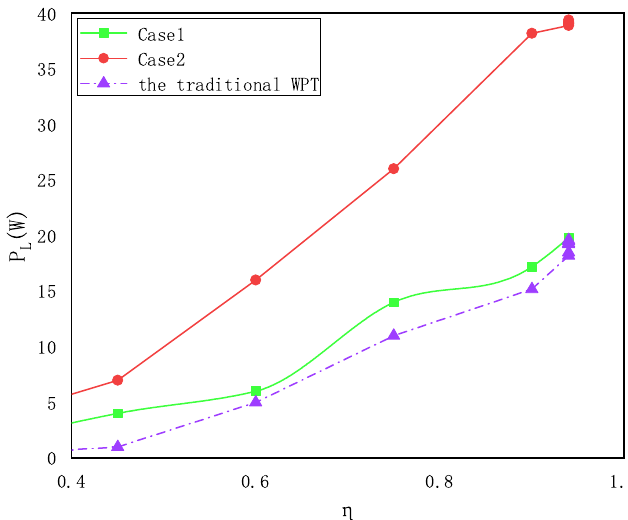
Figure 19. System output power and efficiency against different